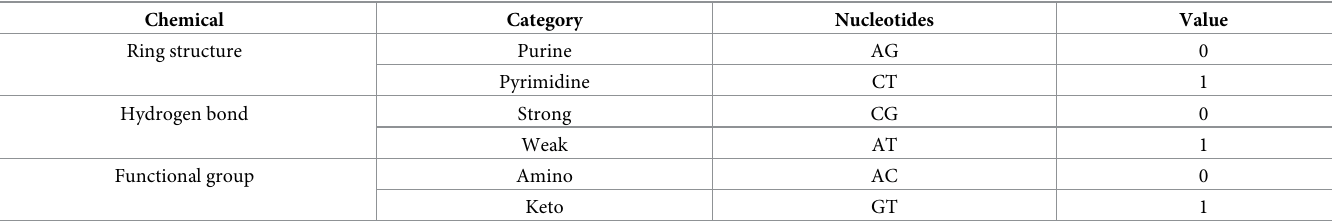
Table 3. Corresponding values for different chemical properties. Chemical Ring